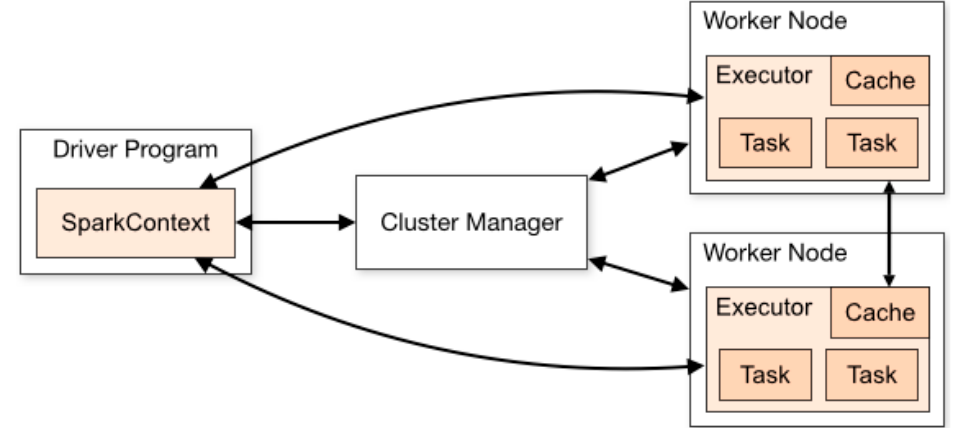
Figure 5. Spark-based cluster operations in the proposed operation.